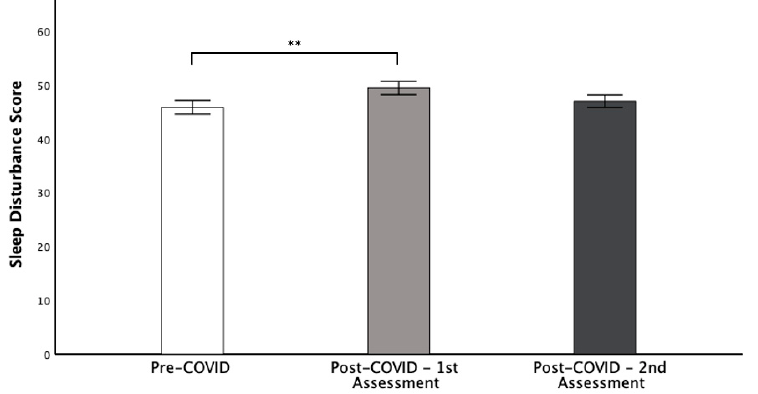
Figure 1. Total CSHQ-DE score pre-COVID-19 vs. post-COVID-19 initial and re-presentation. The sleep disturbance score significantly increased between pre-COVID-19 and 1st assessment (45.82 ± 8.7 to 49.40 ± 8.3, respectively), then decreased (46.98 ± 7.8). Univariate ANOVA with multiple measurements, post hoc Bonferroni (** p ≤ 0.01). Of note, the CSHQ-DE subscale score “daytime sleepiness” significantly increased from pre- to post-COVID-19 (13 ± 3.0 vs. 14 ± 3.2, respectively; p ≤ 0.001) and significantly decreased again at the follow-up (13 ± 3.2; p = 0.029) (Figure 2). All other subscale scores of the CSHQ-DE did not display a change from pre- to post-COVID-19 (Table 5).